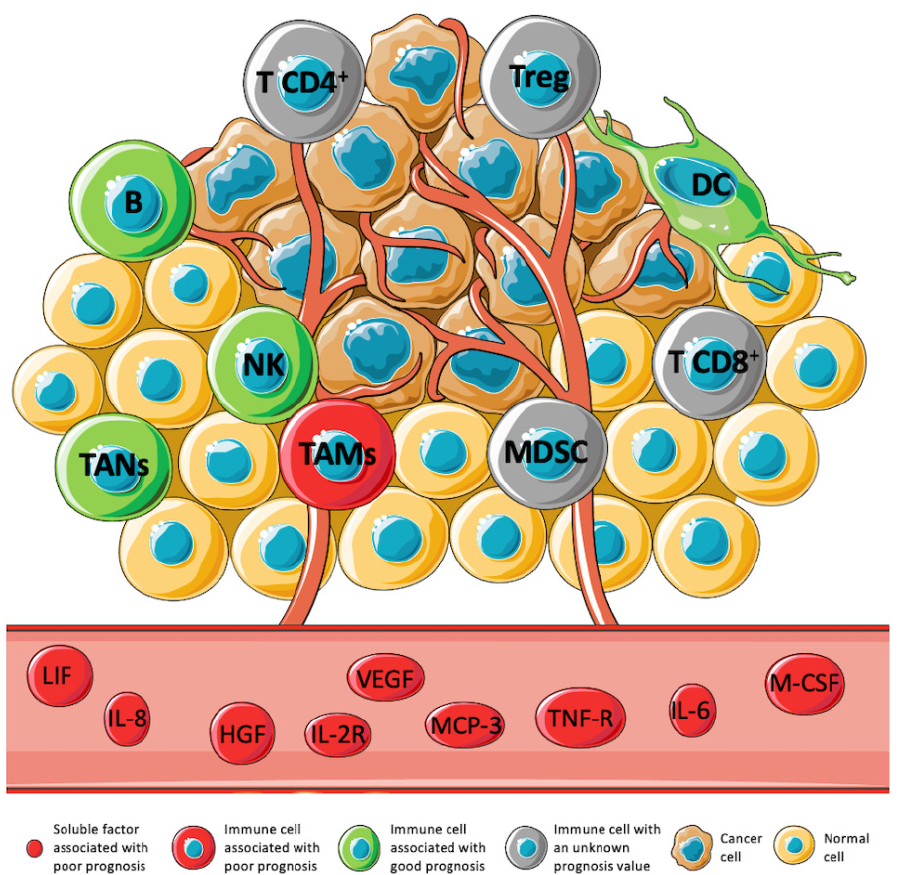
Figure 1. Expression levels of immune cell subtypes, cytokines, chemokines, growth factors, and soluble receptors and their prognostic value in STS. The TME has been associated with the prognosis in several tumors. However, in STS, this association is still underexplored. Immune cells such as B cell, DC, TANs, and NK have been associated with a positive prognosis (green). On the contrary, TAMs, and some soluble factors: LIF, IL-8, HGF, IL-2R, VEGF, MCP-3, TNF-R, IL-6, and M-CSF, have been associated with a negative prognosis (red). The prognostic value of MDSCs, Tregs, CD4 T cells, and CD8 T cells is not clear yet (gray) [11,22,24,26,40,42,44–47].